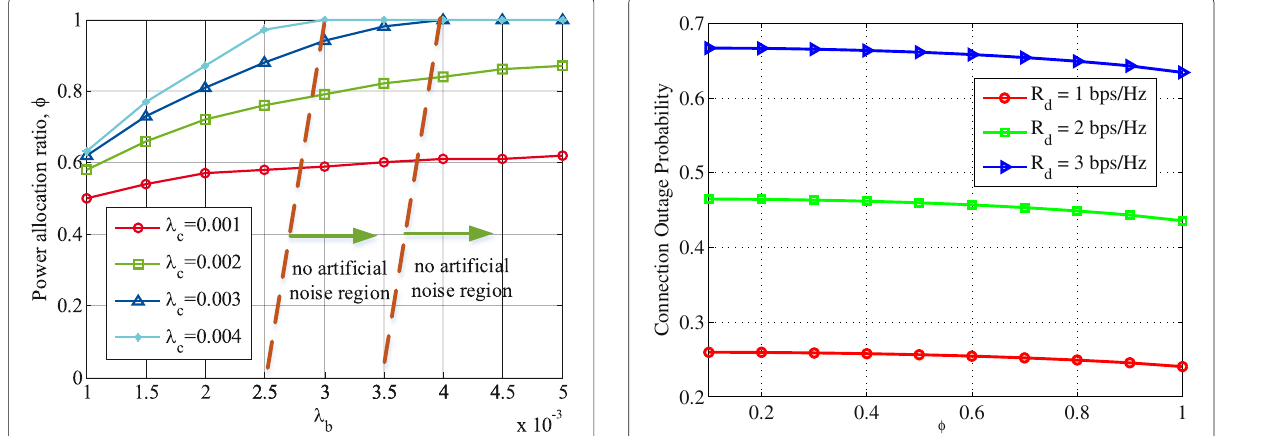
Fig. 7 The power allocation ratio in scenario I versus the density of the base station λ b where λ e = 0.0003 / m 2 , R e = 0.5 bps / Hz , ε = 0.1. Figure 7 illustratesthe transmission power allocated totheinformation- bearing signalunderthedensityofthe base station , andshowsthatitis unnecessarytogeneratetheartificial noise under specific condition